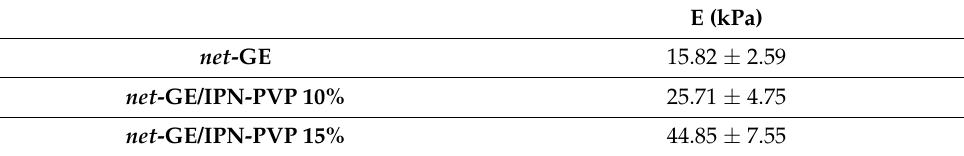
Table 3. Elastic modulus of gelatin-based hydrogels.